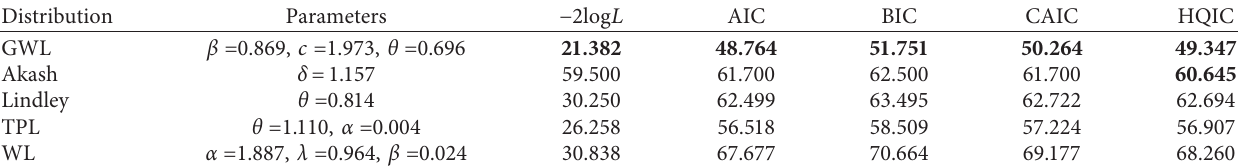
Table 4: Analysis results of remission dataset by Gross and Clark